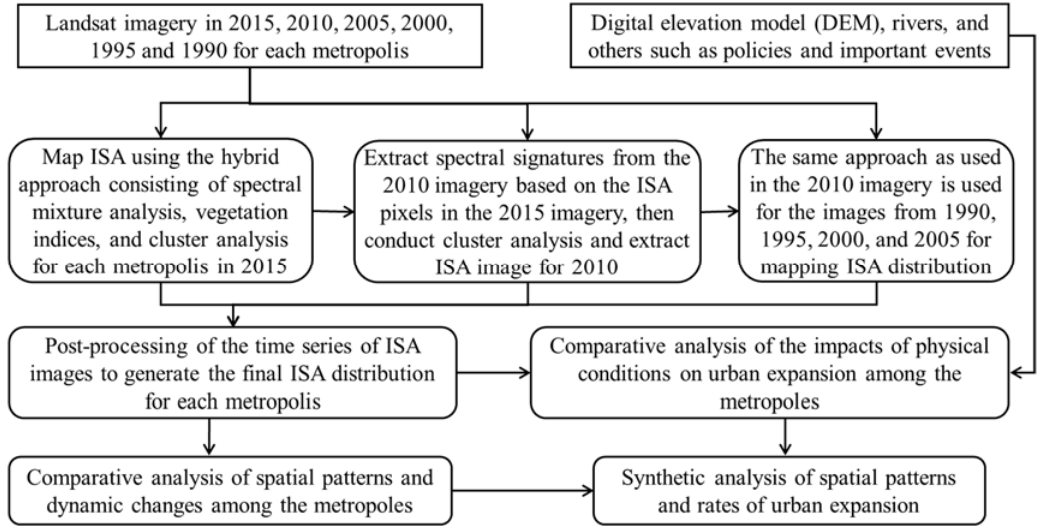
Figure 2. Framework for mapping impervious surface area (ISA) distribution, examining spatial patterns of urban expansion, and analyzing the impacts of physical conditions on urban expansion among the six metropoles selected for study.